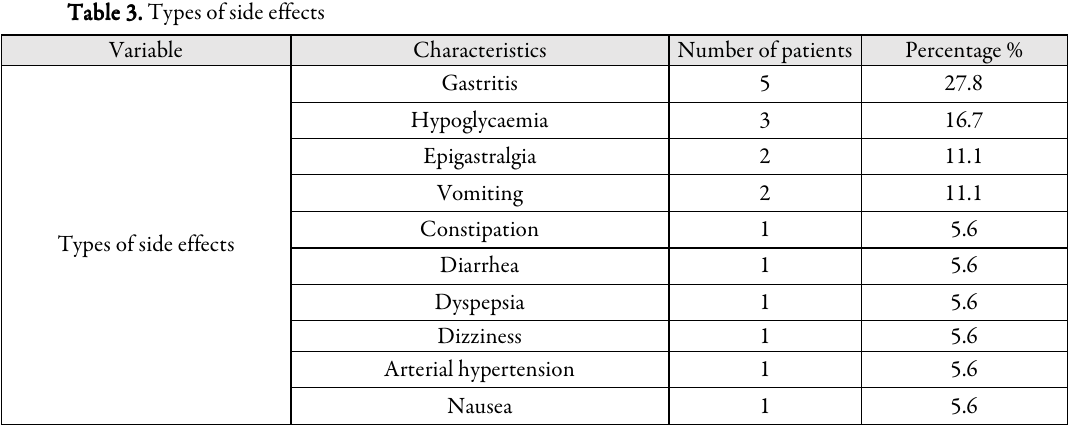
Table 3. Types of side